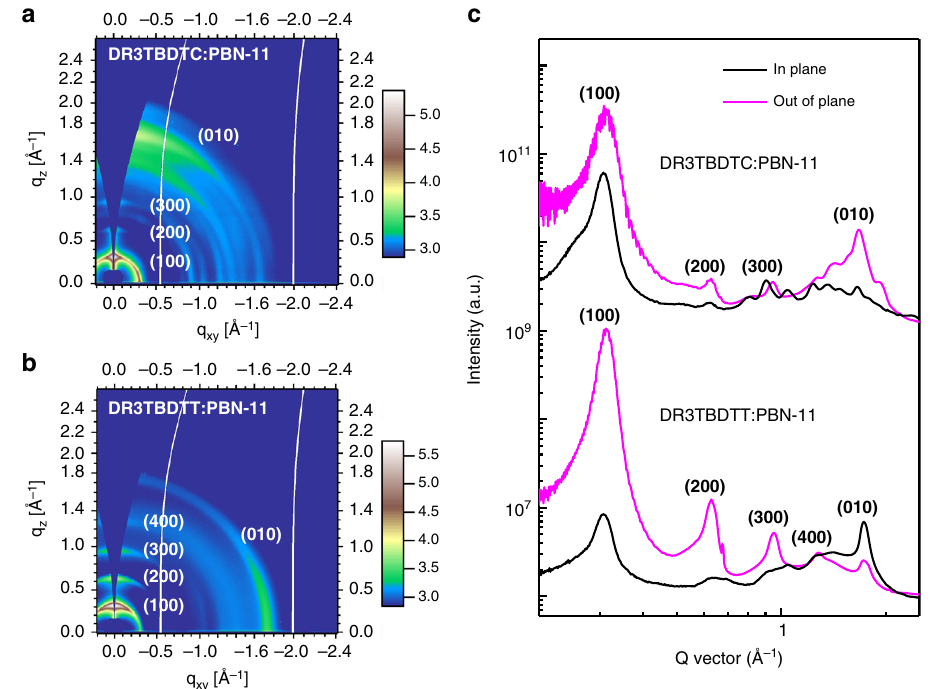
Fig. 4 GIWAXS data for the blend fi lms. 2D-GIWAXS patterns of a DR3TBDTC:PBN-11 and b DR3TBDTT:PBN-11 blend fi lms. c 1D Linecuts of the corresponding 2D-GIWXAS patterns in the in-plane and out-of-plane directions